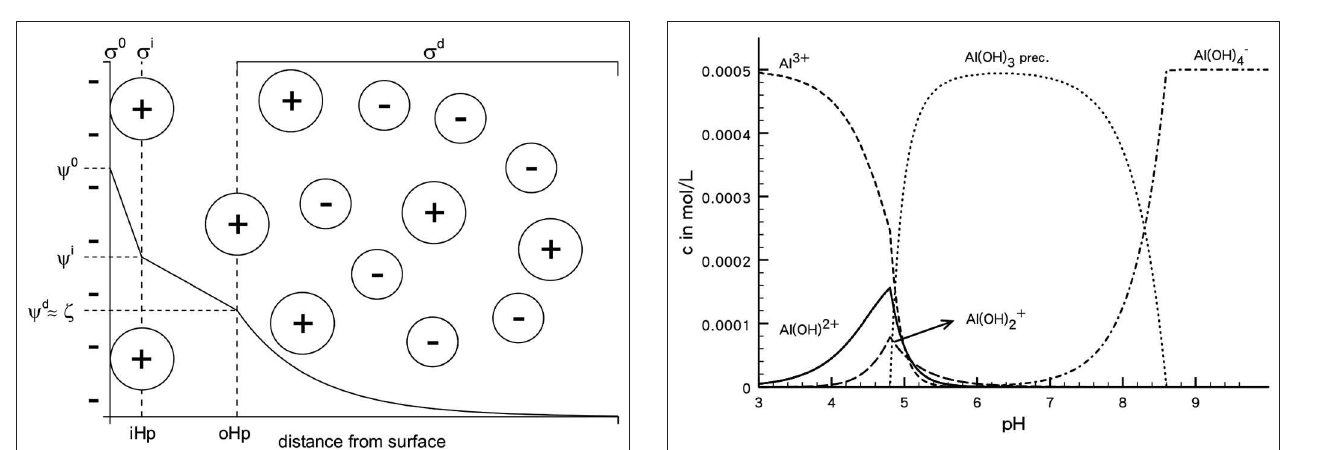
FIGURE 1 | Schematic model of the electric double layer including a Stern- and a diffuse layer. determined by the size of the specifically adsorbed species. Note purely electrostatic attraction, additional attraction to the surface.